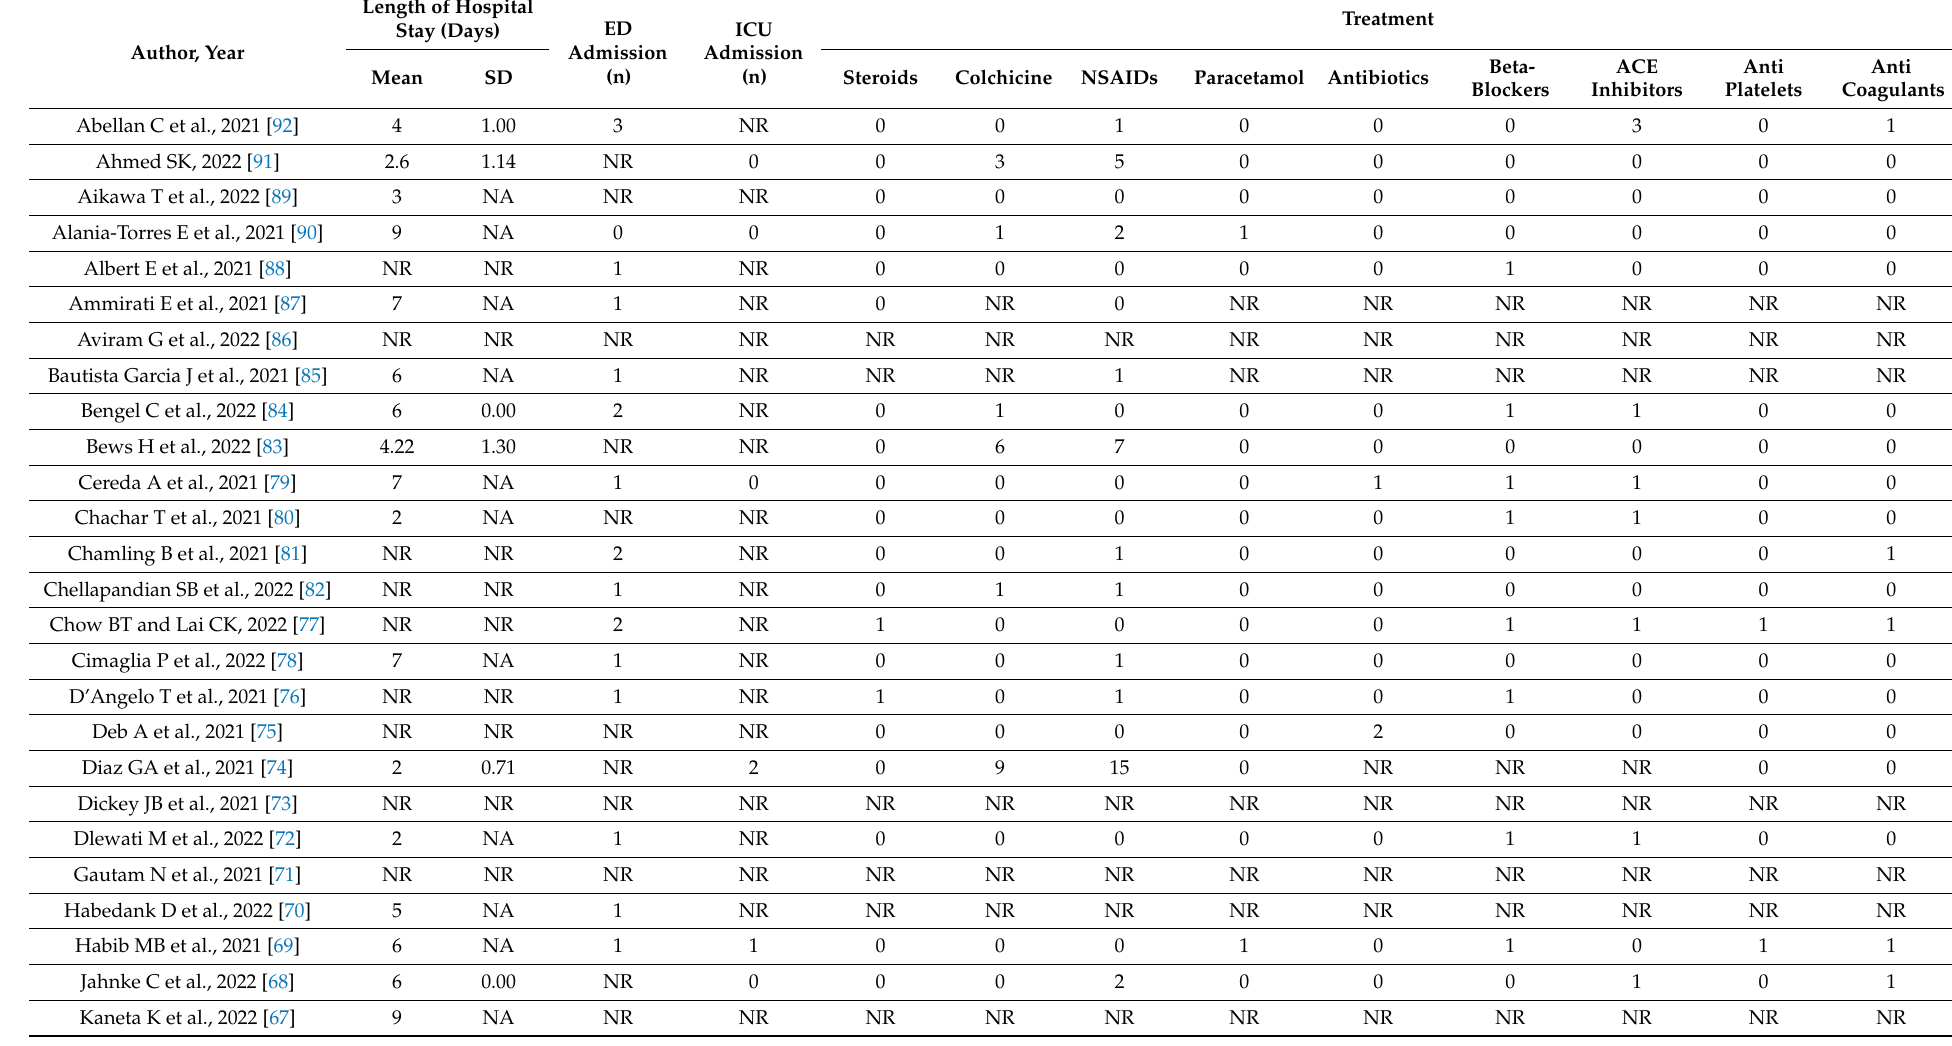
Table 5. Clinical Course and Common Treatment Details of Patients